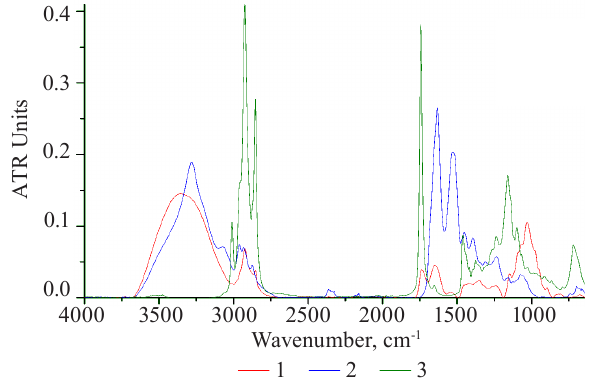
Figure 1 IR-spectra of different classes of substances: (1) dry flaxseed polysaccharide (2.4% protein), (2) dry egg albumin,